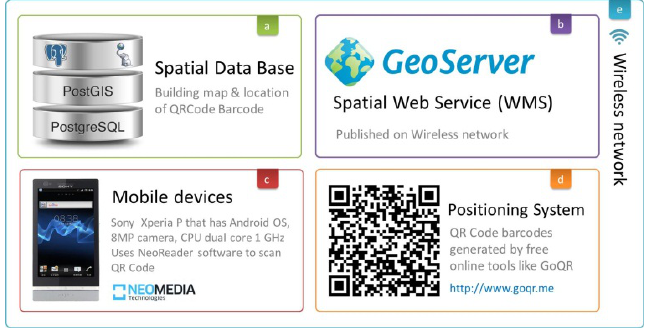
Figure 3. Component of implemented LBS system (a.Data Provider, b.Service Provider, c.Mobile Device, d.Positioning System, e.Communication Network)